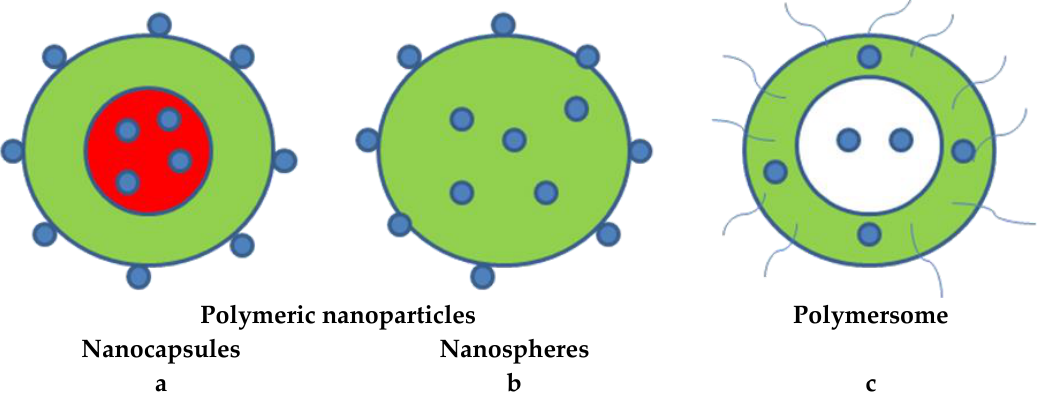
Figure 7. Types of polymeric nanocarriers: ( a , b ) The polymeric nanoparticles where active ingredients are conjugated to or are encapsulated in polymers. ( c ) A polymersome composed of hydrophilic-hydrophobic block copolymers, arranged in a lipophilic bilayer vesicular system and with a hydrophilic inner